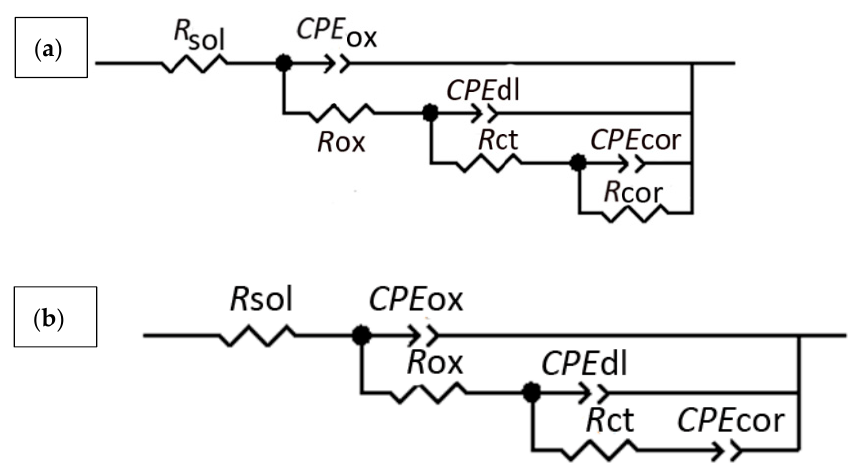
Figure 7. Equivalent electrical circuits (EEC) proposed to fit the data of the AA2024-T3 and AA2524- T3 ( a ) until 9 h and ( b ) from 11 h of immersion in a 0.01 mol L − 1 NaCl solution. Table 4. Parameters obtained from the equivalent electrical circuit fitted to the AA2024-T3 and AA2524-T3 EIS data. 2 h